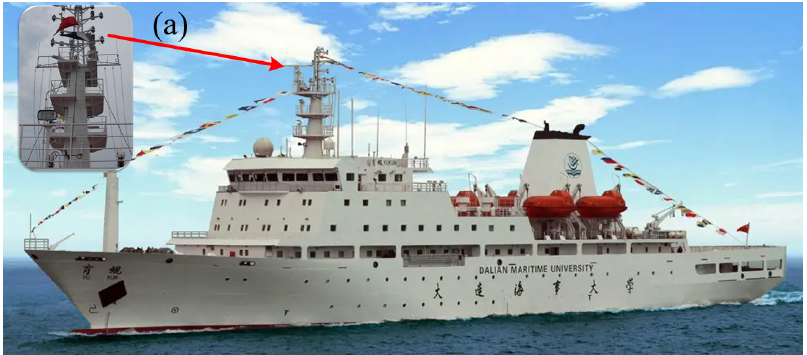
Figure 2. The experimental data acquisition platform. ( a ) The shipborne radar installation position. Table 1. The shipborne radar-specific parameters.